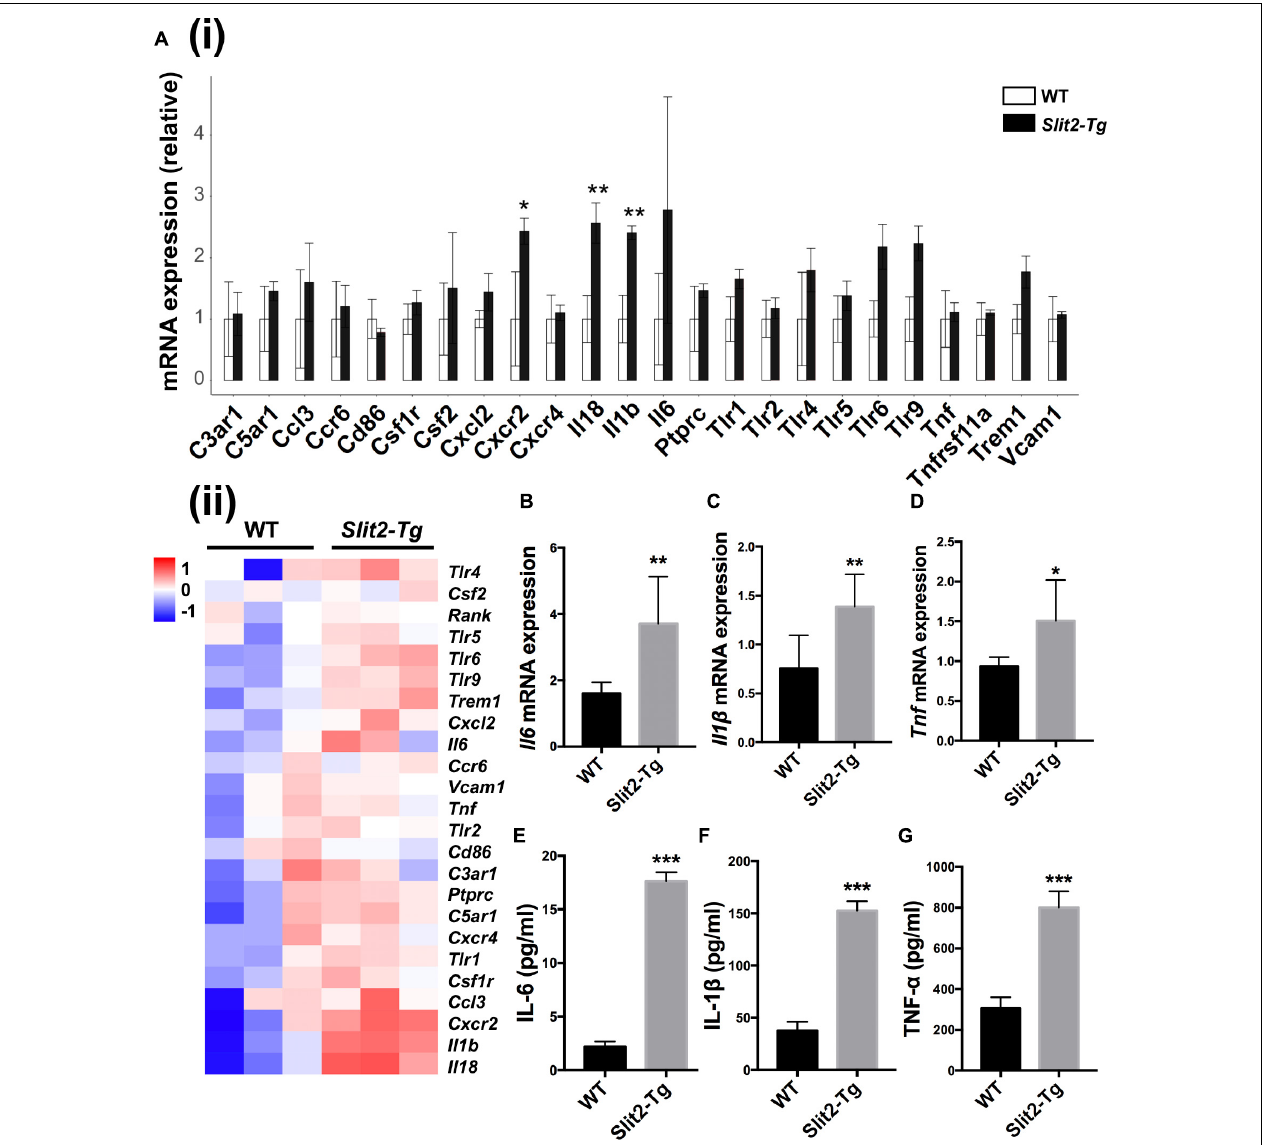
FIGURE 3 | SLIT2 overexpression triggers up-regulation of periodontal inflammatory factors. (A (i)) Relative mRNA expression, and (A (ii)) Heat map showing the differential expression pattern of inflammatory markers in PAPT analyzed by RNA sequencing ( n = 3). Relative mRNA expression of (B) Il6 , (C) Il1 β , and (D) Tnf α in periodontitis-affected tissue analyzed by RT-qPCR. Protein expression of, (E) IL-6, (F) IL-1 β , and (G) TNF- α in periodontitis-affected tissue analyzed by ELISA. Data are presented as mean ± SD ( n = 6). Data are presented as mean ± SD. The significant difference among the groups, * P < 0.05, ** P < 0.01, *** P < 0.001. Red color intensity indicates upregulation, and blue color intensity indicates the downregulation of gene